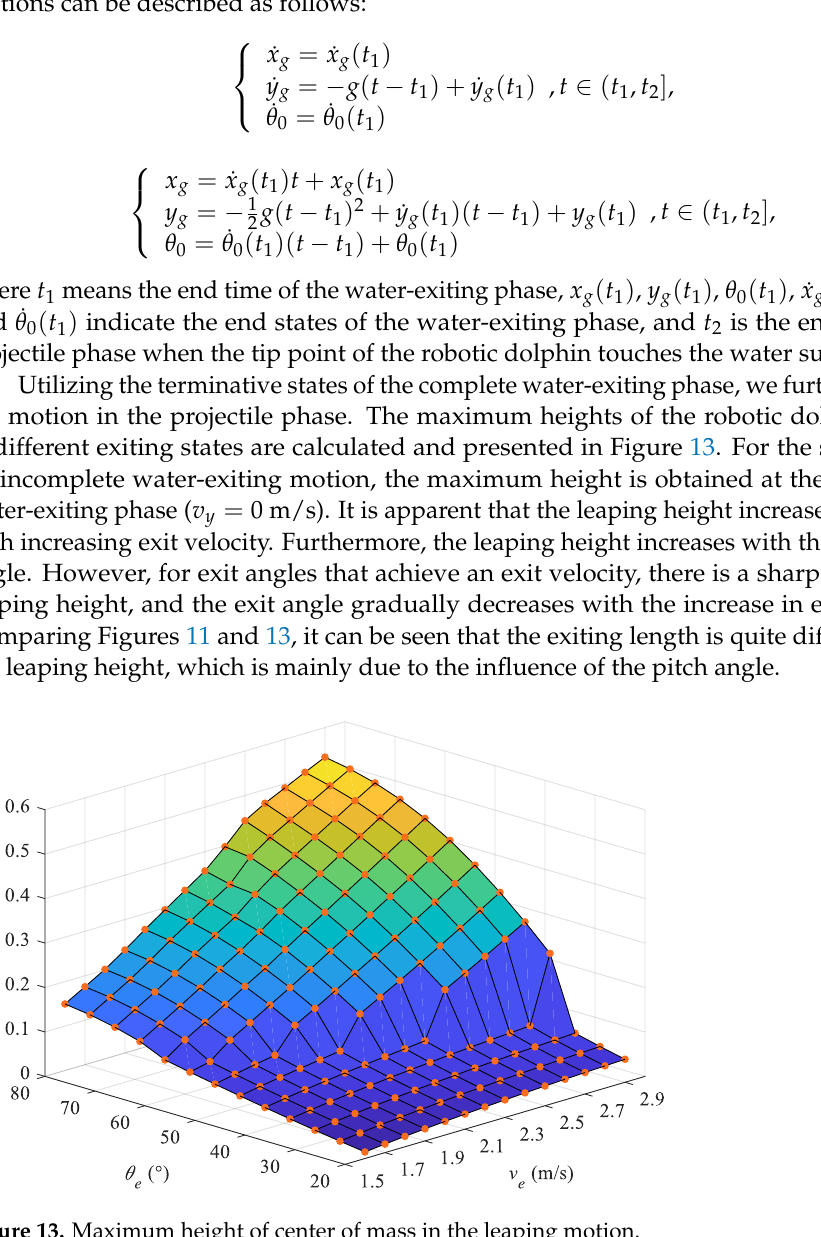
Figure 13. Maximum height of center of mass in the leaping